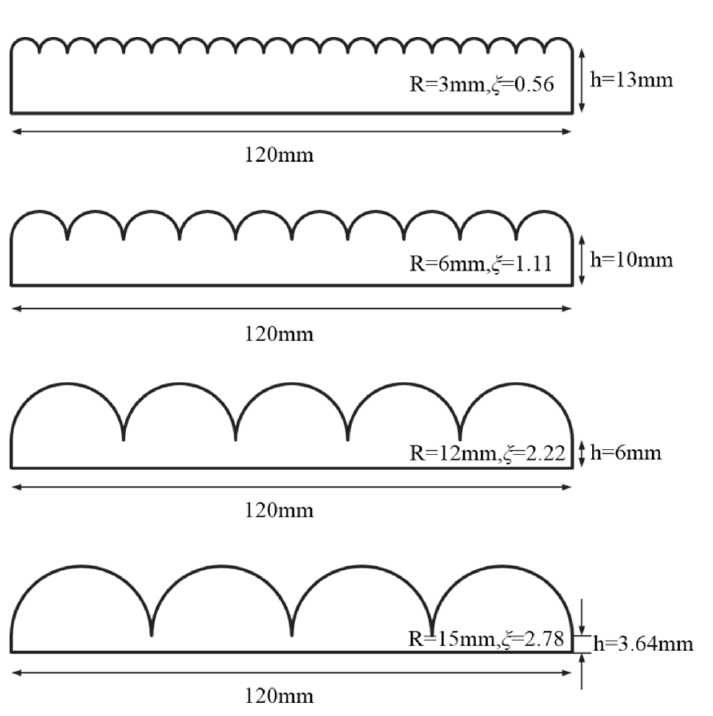
Figure 10. Schematic diagram of the cross-section of composite armors with different ratios of semi-cylindrical ceramic diameter to core diameter under equal areal density. Table 4. Working conditions for calculation.